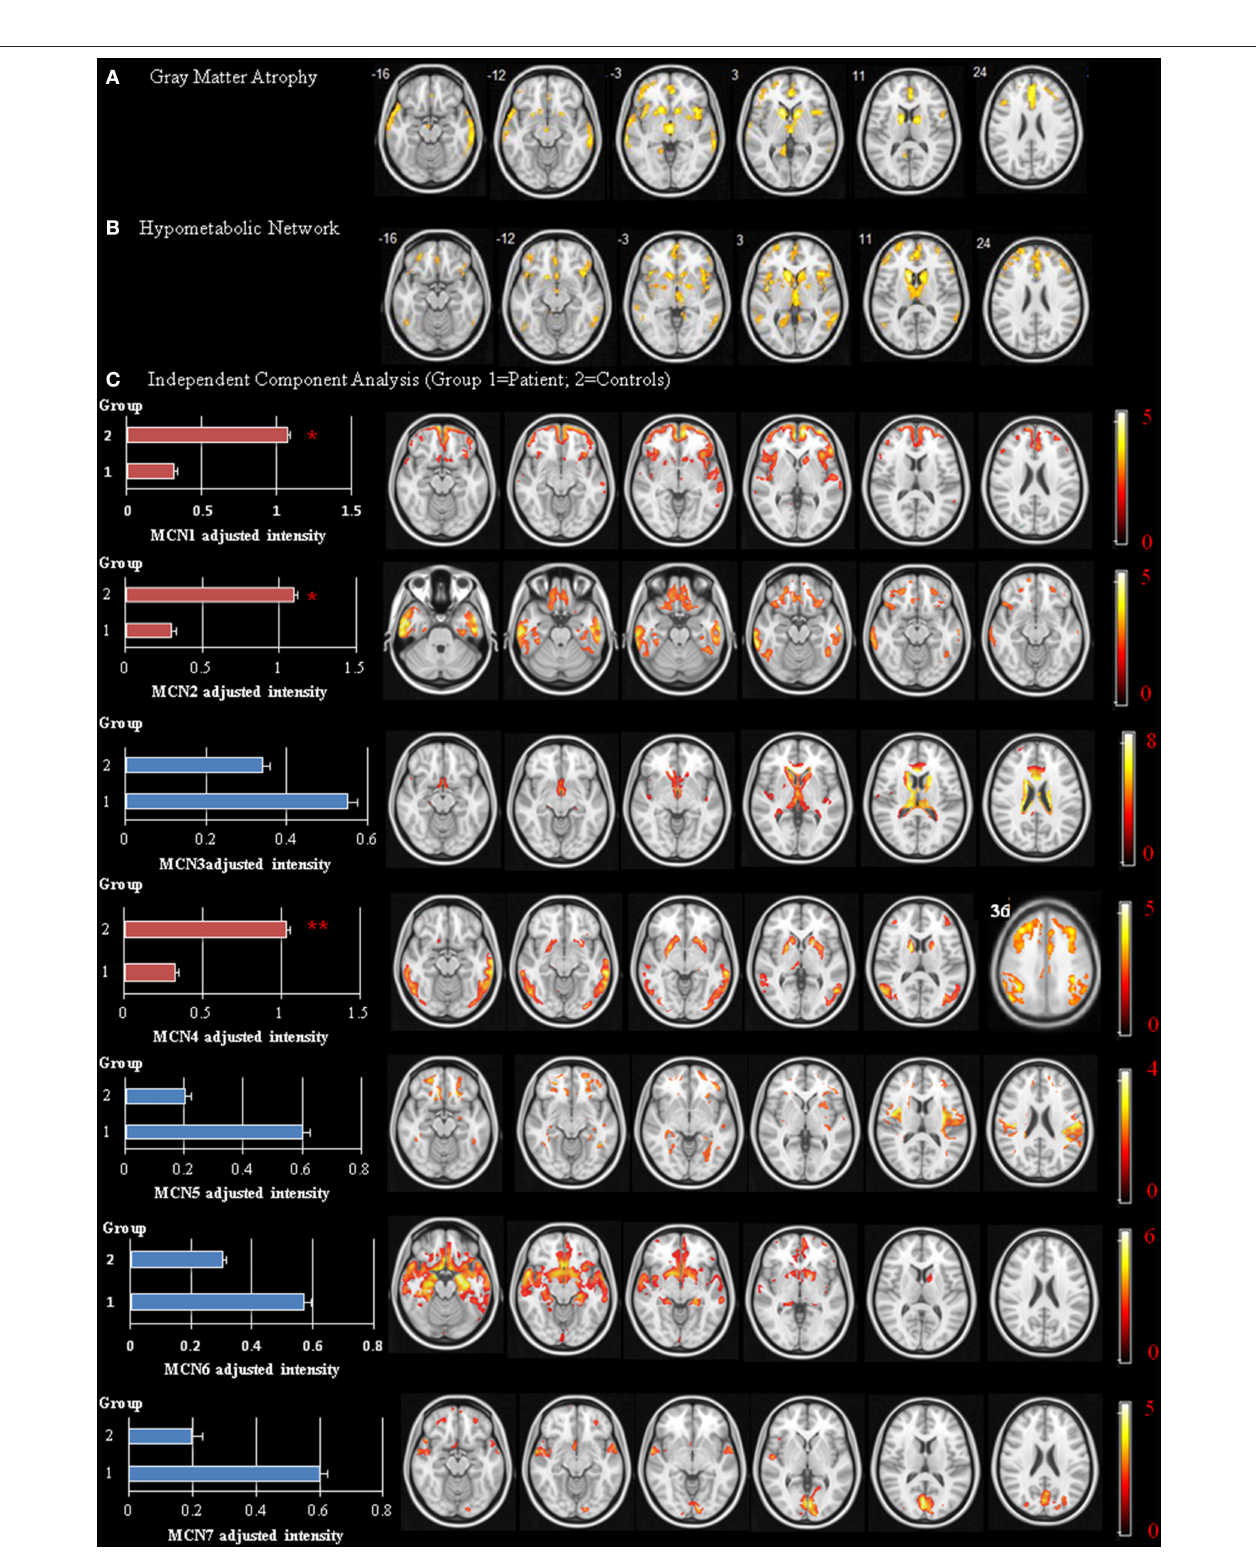
FIGURE 2 | Disease-specific network showing significant differences between the patients and controls. Voxel-based morphometry of gray matter (GM) volume (A) and positron emission tomography (PET) signals using occipital cortex as reference region (B) Independent Component Analysis of PET (C) Image results overlay on the T1 template and color bar represents t -value ranges. MCN, metabolic covariant network. * p < 0.05, ** p < 0.01 .